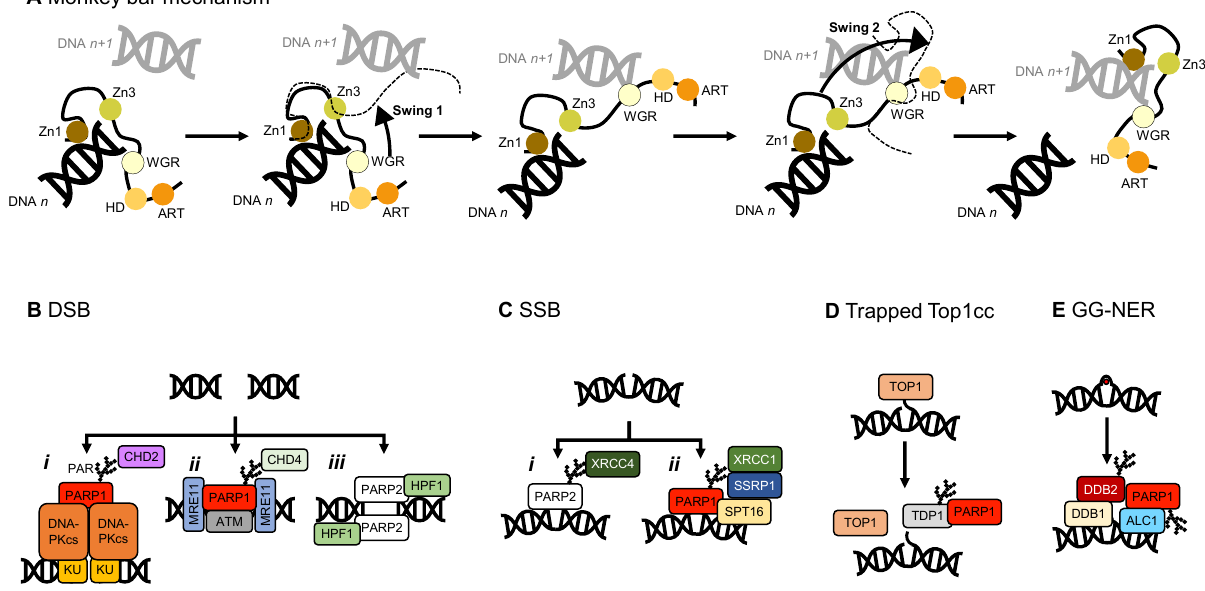
Figure 6. A schematic showing how PARP1 recognises DNA damage, and examples of the roles of PARP1 and PARP2 in initiating DDR and chromatin remodeling. ( A ) The monkey bar mechanism [99]; ( B ) PARP1/2 initiating DSB repair. i. PARP1 interacts with DNA-PK [79] and recruits the chromatin remodeler CHD2 [174] in the canonical NHEJ pathway. ii. PARP1 plays a role in the alternative NHEJ pathway, interacting with MRE11 (part of the MRN complex, [84]), ATM, and recruiting the CHD4 subunit of the NuRD complex [166,167]. iii. PARP2 recognises a DSB along with HPF1 [53,150]; ( C ) PARP1/2 initiating SSB repair. i. PARP2 plays a role in recognising SSBs and recruiting XRCC4 [175]. ii. PARP1 can also recognise SSBs and recruit XRCC1 [78,176], and subsequently the FACT complex (SSRP1 and SPT16; [176]); ( D ) PARP1 recruits TDP1 to release trapped TOP1 cleavage complexes (Top1cc) [79]; ( E ) PARP1 is involved in global genome nucleotide excision repair (GG-NER), recruiting DNA damage-binding protein 1 and 2 (DDB1/2) and the chromatin remodeler ALC1